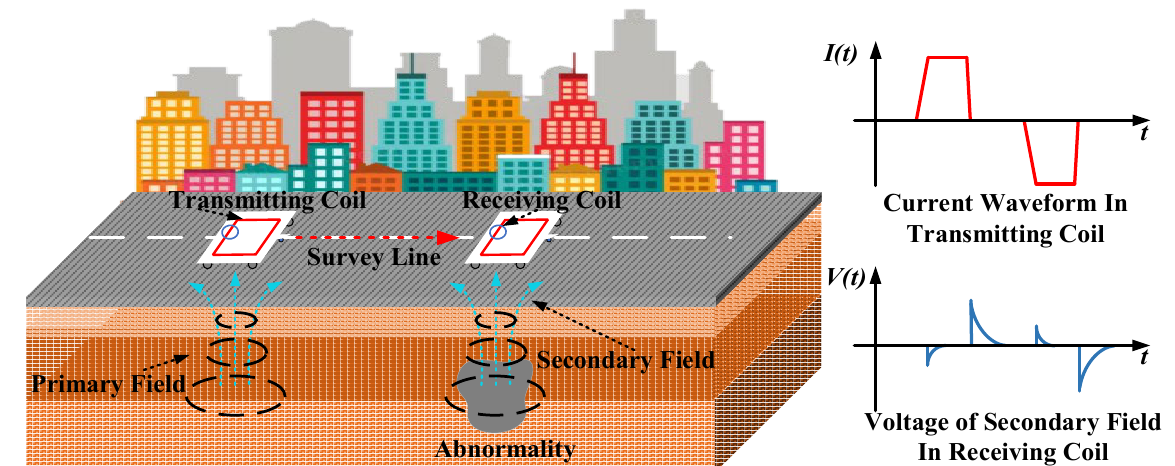
Figure 1. Schematic diagram of TEM survey.